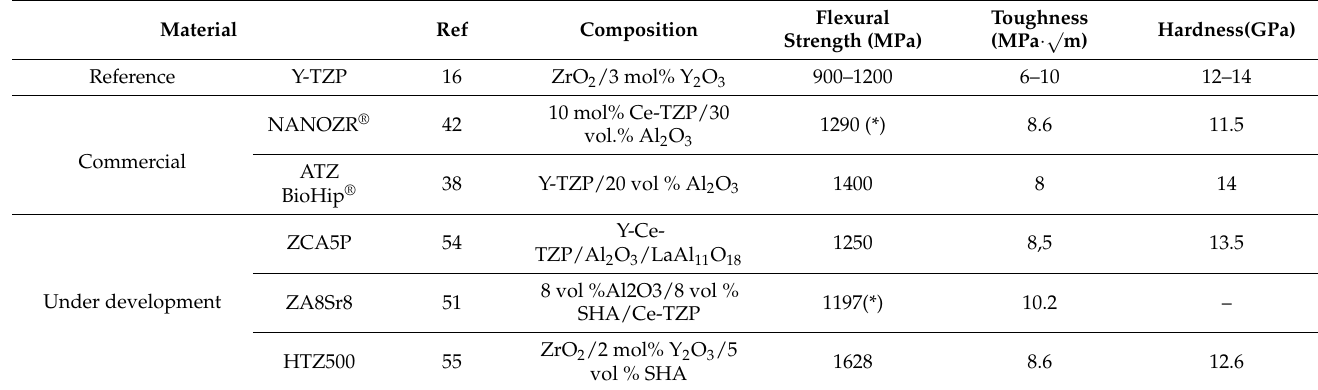
Table 4. Selected characteristics of some ZTC of interest as materials for dental implants. Flexural strength measured on 4-p bending bars. * Biaxial measure on discs following ISO